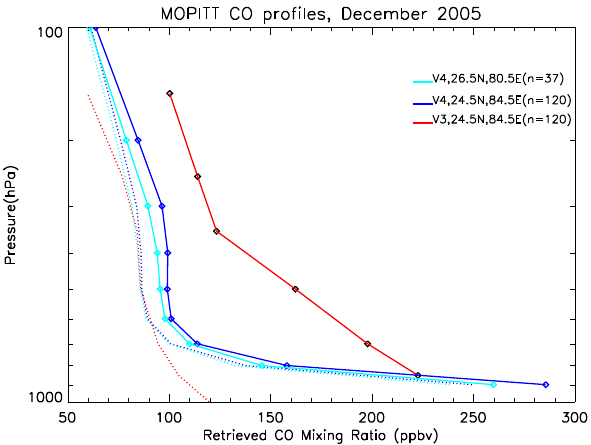
Fig. 2. Evolution of the pollution over Eastern IGP in MOPITT CO retrievals (version 4, level 3) at 900hPa level. Only the dayside data with mean uncertainty less than 50% have been used for these